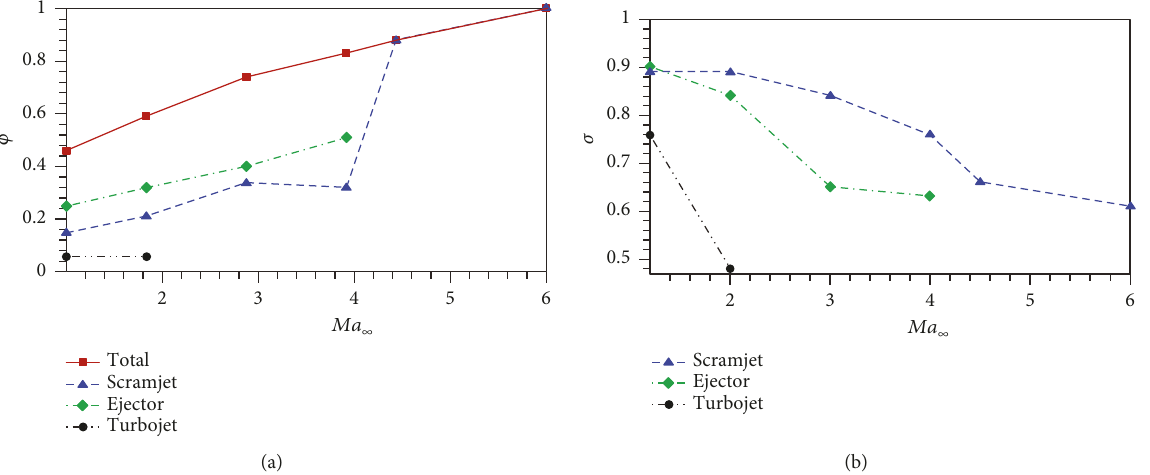
Figure 13: (a) Mass fl ow ratio of the inlet (with total and each single duct) at di ff erent Mach numbers. (b) Total pressure recovery of the inlet at di ff erent Mach